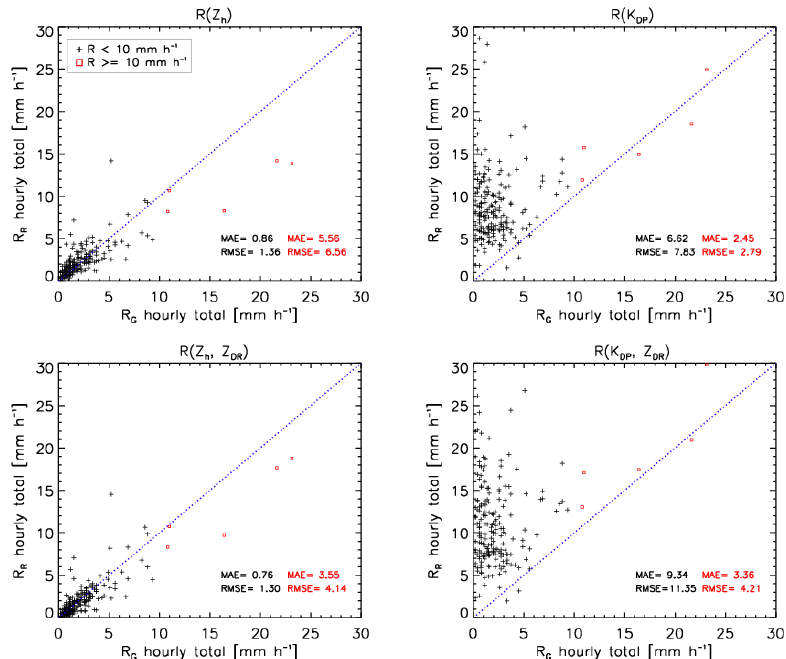
Figure 8. Scatter plots of the 1h rain rates from rain gauge ( R G ) and BSL S-band radar based on Eq. (4) for 18 rainfall cases. The pluses represents 1h gauge rain rates vs. radar hourly rain rates from polarimetric rainfall algorithms for a light rain rate ( R <10mmh − 1 ) , and squares indicate those for a heavy rain rate ( R ≥ 10mmh − 1 )